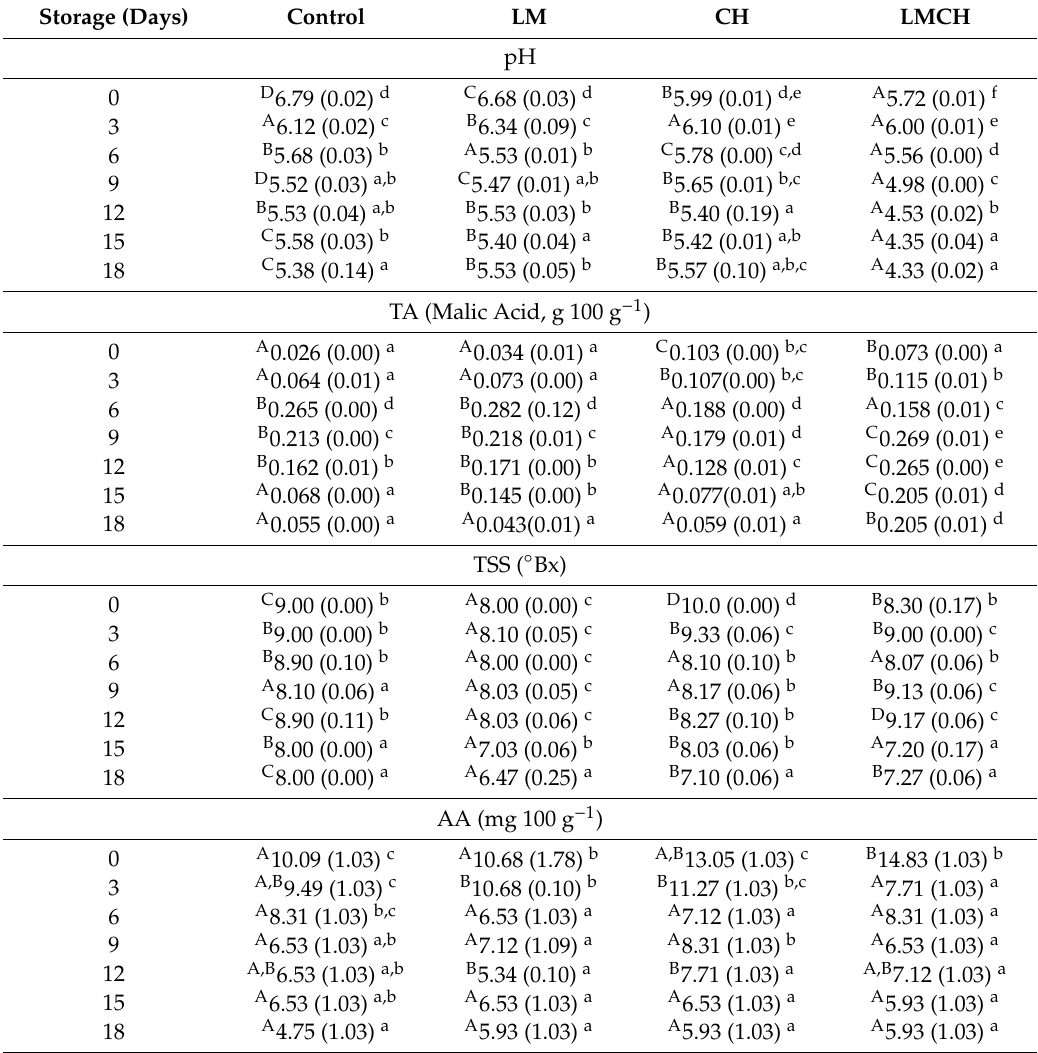
Table 2. Chemical properties of fresh-cut cantaloupe with and without EC (control), during 18 days of storage at 4 ◦